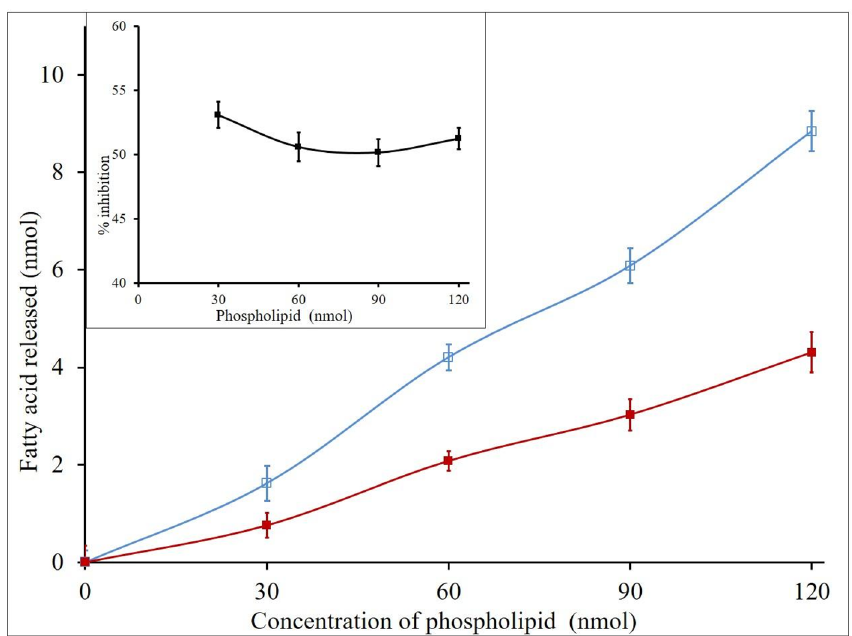
Figure 7. Effect of substrate concentration on inhibition of GIIA by elemolic acid: The reaction was performed with (red filled square) and without (blue open square) IC 50 concentration of elemolic acid; the substrate concentration increased from 30 to 120 μL. The GIIA inhibition was recorded in the presence of IC 50 concentration of elemolic acid and has shown inlet. The data are expressed in mean ± standard deviation (n =